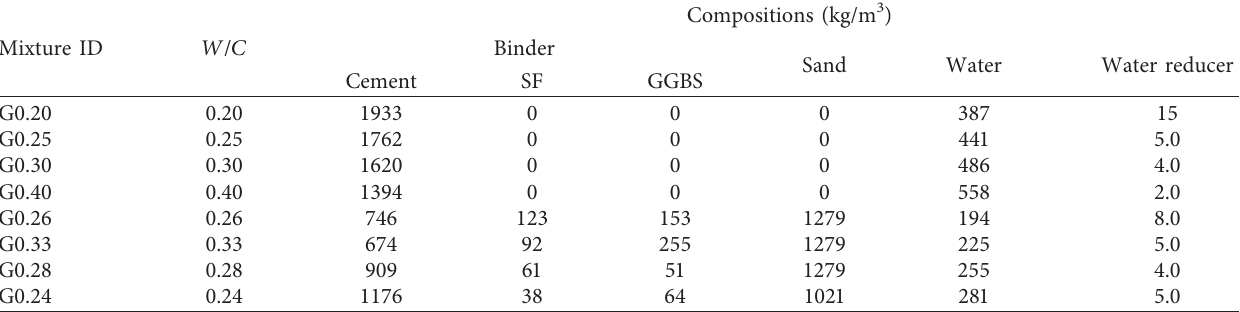
Table 2: Mixture proportions of grout.